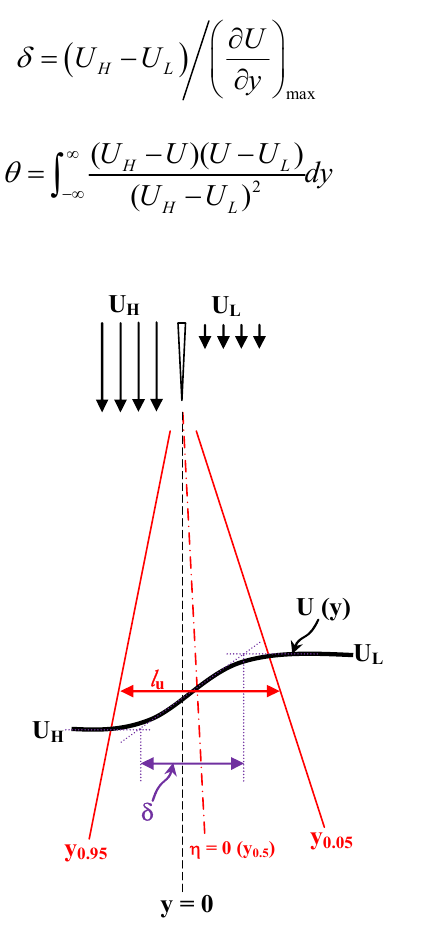
Figure 1 Schematics of the mixing length ( l Rogers and Moser (1) performed DNS computation and found that both growth rates of δ and θ become linear, which is the same trend as for that of l 4.8 after the achievement of the self-preserving state in turbulent mixing layer. It is well agreed (2 4) − that linear growth rate of l self-preserving state in turbulent mixing layer. It is worthy to note that l